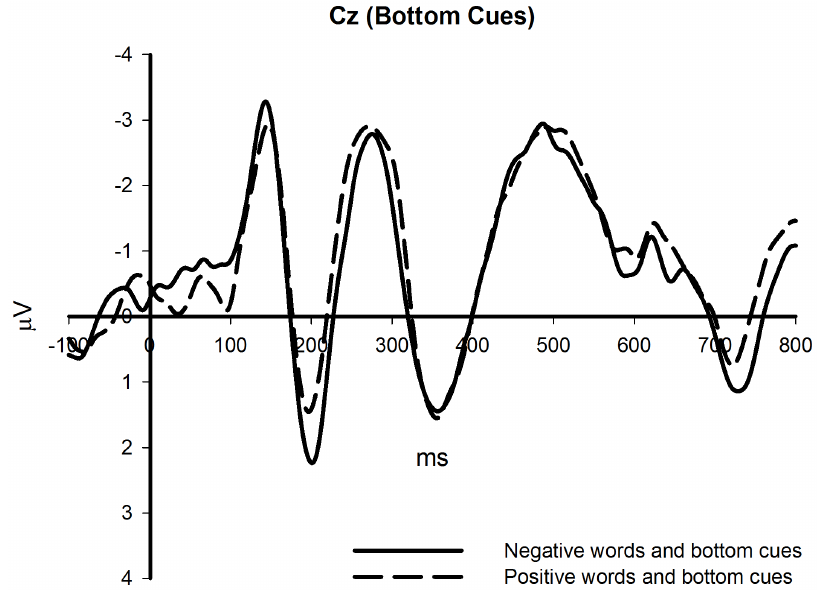
Figure 2. The effects of different affective words on bottom cues (Cz site).